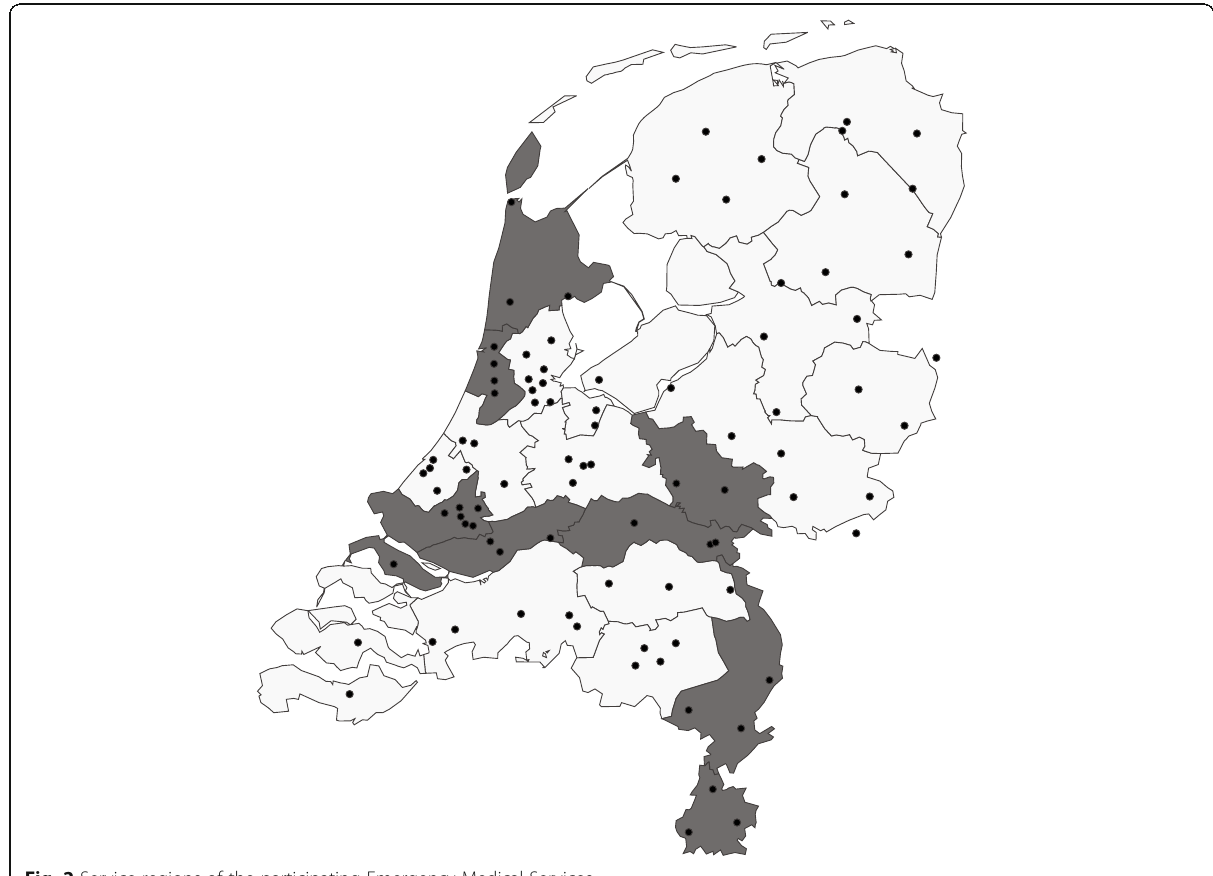
Fig. 2 Service regions of the participating Emergency Medical